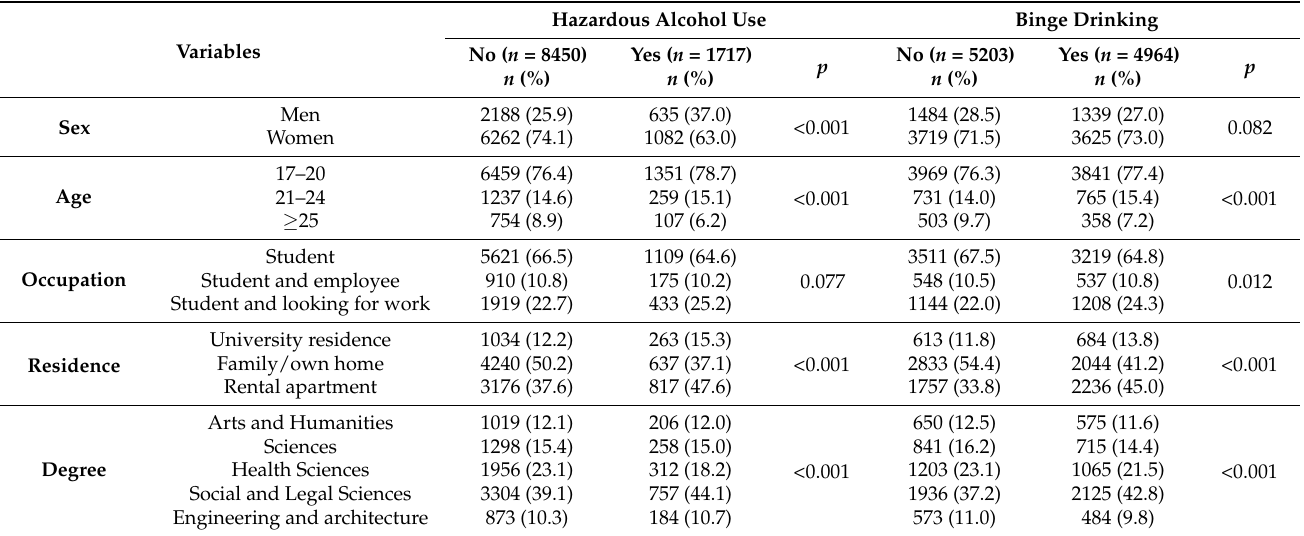
Table 2. Patterns of alcohol use in university students according to sociodemographic and occupa- tional variables.